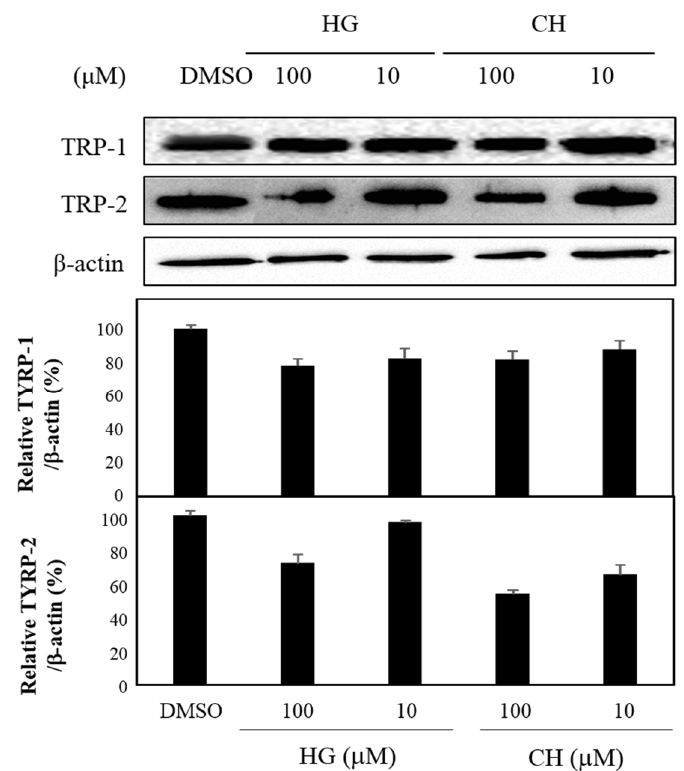
Figure 6. E ff ects on TYRP-1 and TYRP-2 expression of HG and CH. The data are expressed as the mean ± SD ( n = 3) of three individual experiments.